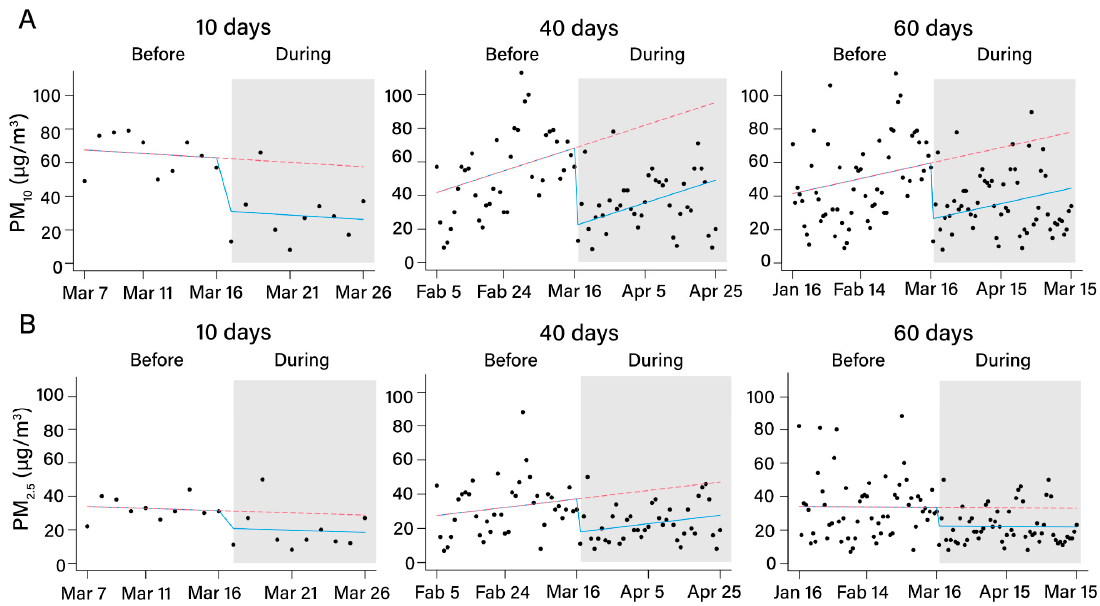
Figure 4. ITS analysis of daily PM 10 and daily PM 2.5 concentrations after implementing the home office order for different times. ( A ): ITS analysis of daily PM 10 concentrations after implementing the home office order for different times; ( B ): ITS analysis of daily PM 2.5 concentrations after implementing the home office order for different times. The pink line indicates the trend of PM concentration without intervention and the blue line indicates the trend after intervention. Table 3. Variation of daily PM 10 and PM 2.5 concentrations after the different duration of the home office order by ITS analysis.